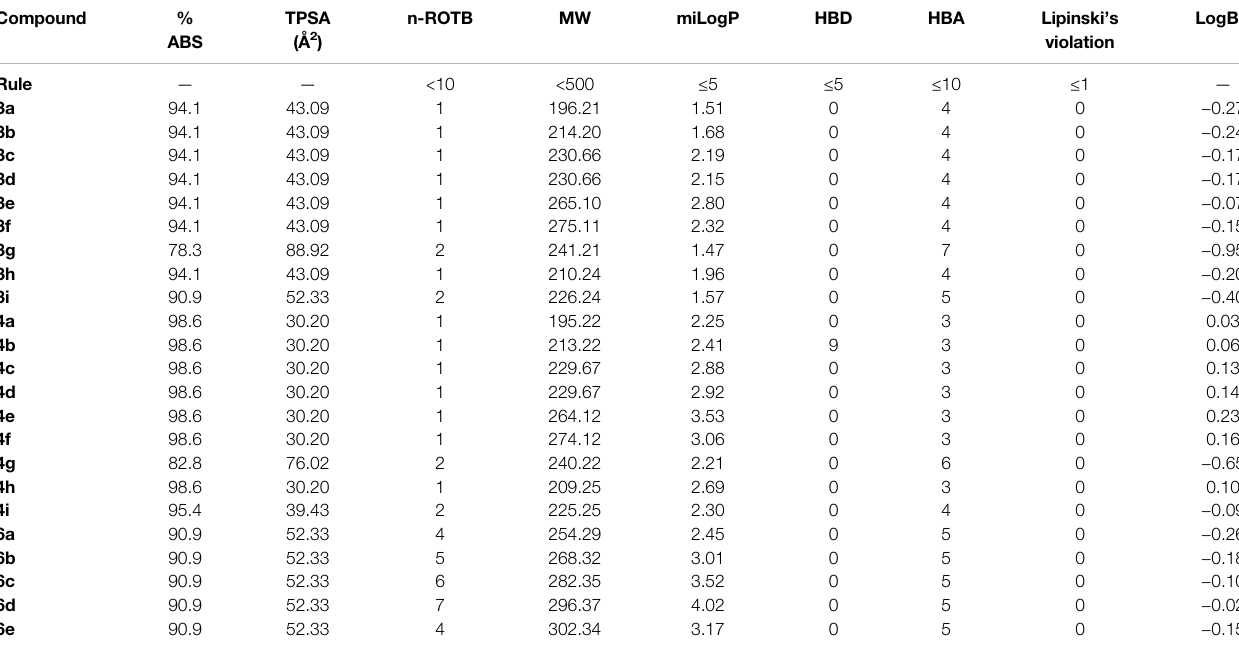
TABLE 7 | Pharmacokinetic parameters important for good oral bioavailability and drug likeness of targets compounds 3a – 3i , 4a – 4i , and 6a – 6e .